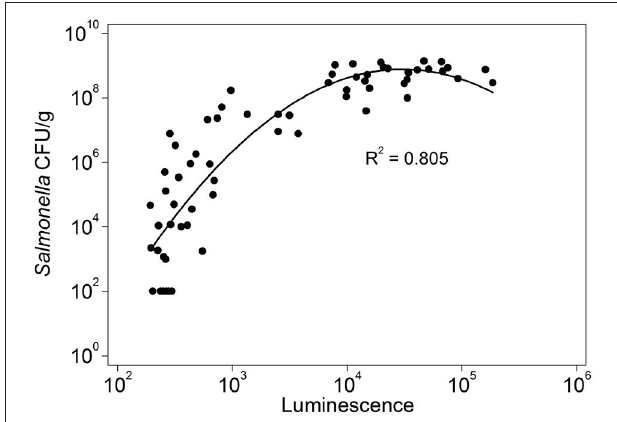
FIGURE 3 | Correlation between luminescence and Salmonella cell numbers in the cecum of chicken experimentally infected with S . Heidelberg- lux or S . Typhimurium- lux strains. Salmonella cell numbers (log 10 ) in the cecum was plotted against luminescence (log 10 ) detected using the IVIS bioluminescence imaging system. Background luminescence was set at the upper range of signal detected (luminescence log 10 2.82) in tissues from un-inoculated controls. A positive correlation ( r 2 = 0.805) was observed between luminescence (log 10 photons/sec/cm ² /sr) and cell density (log 10 CFU/g).